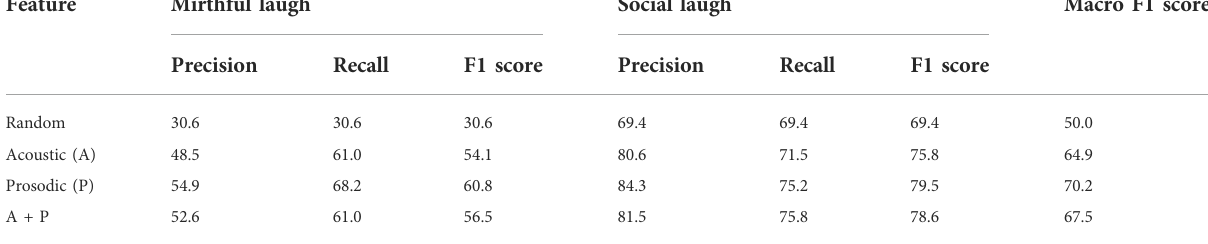
TABLE 4 Laughter type selection performance